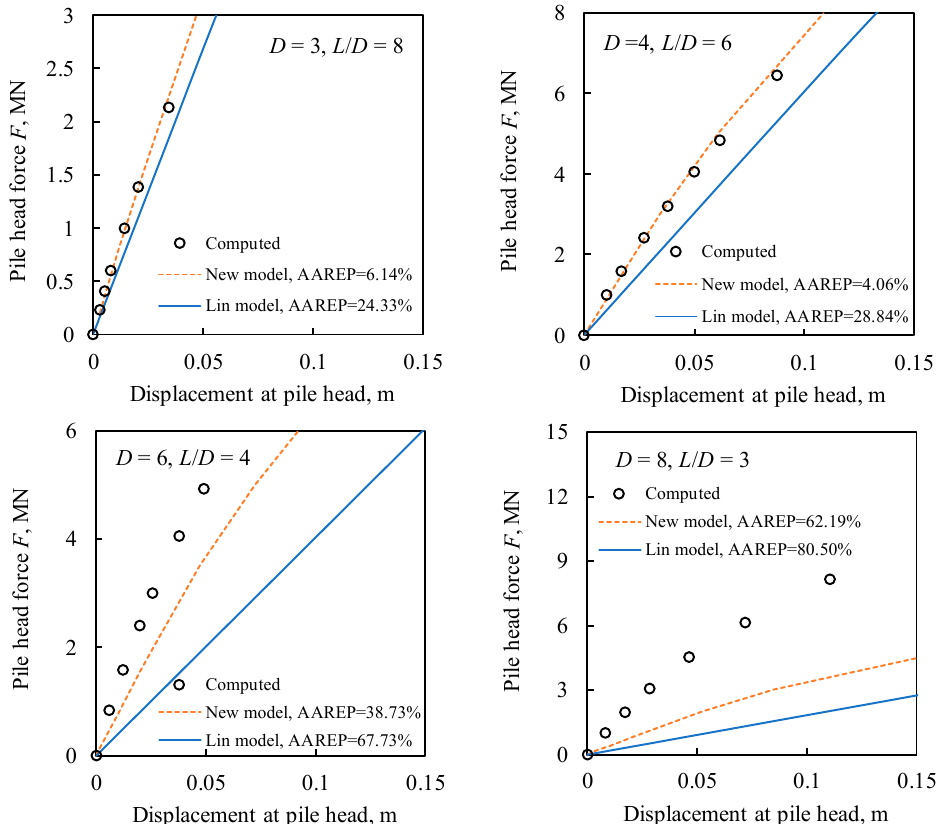
Figure 14. Comparison of the proposed model using monopiles with various diameters.